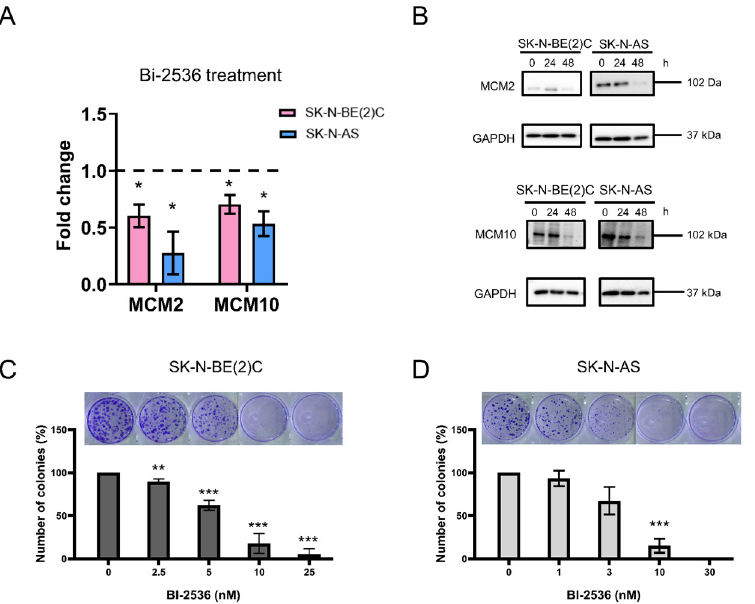
Figure 4. BI-2536 inhibited the expression of MCM2 and MCM10 and the proliferation of neuroblastoma cells: ( A ) MCM2 and MCM10 mRNA expression was decreased by BI-2536. The cells were treated with the half maximal inhibitory concentration (IC 50 ) of BI-2536 for 24 h. * p < 0.05 from one-sample t -test to determine whether the group mean value differs from 1. ( B ) The protein levels of MCM2 and MCM10 were decreased in SK-N-BE (2) C and SK-N-AS cells following treatment with BI-2536 for 24 or 48 h; glyceraldehyde-3-phosphate dehydrogenase (GAPDH) was used as an internal control. The cells were treated with the IC 50 of BI-2536 for 24 and 48 h. ( C , D ) BI-2536 reduced proliferation in neuroblastoma cells. The number of colonies was significantly reduced by >50% after treatment with 10–30 nM BI-2536 in SK-N-BE (2) C and SK-N-AS cells. ** p < 0.01, *** p < 0.001 from two-tailed unpaired Student’s t -test to determine whether the mean value of a given group is equal to the corresponding DMSO alone group.